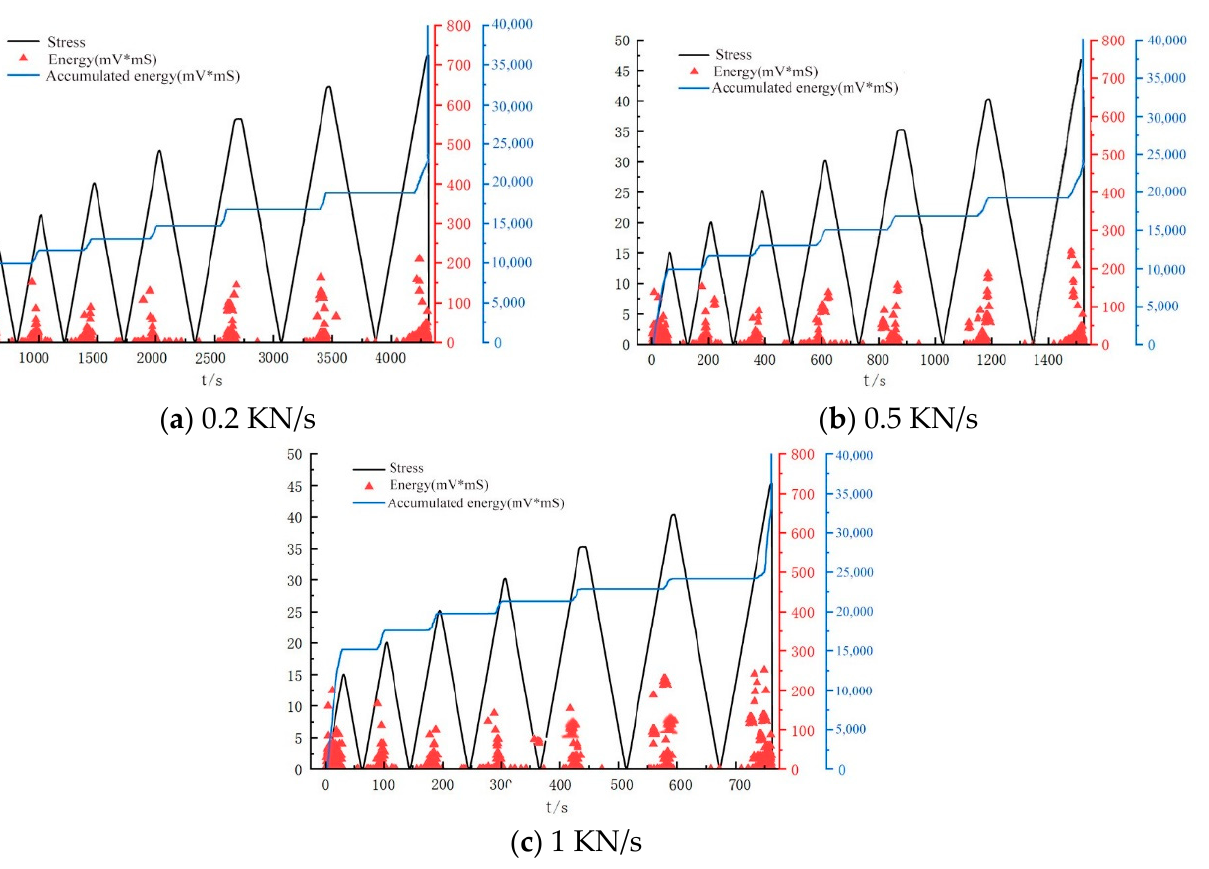
Figure 15. Acoustic emission characteristics of sandstone. The test results show that there is a relatively active acoustic emission signal at the beginning of loading, after which the acoustic emission signal is somewhat weakened, compared with the beginning of loading. With the continuation of cyclic loading and unloading, the stress at the unloading point increases, and the redeveloped microcracks keep appearing. The acoustic emission signal tends to be active, and the acoustic emission energy increases. This means an increase in dissipated energy, which is consistent with the aforementioned dissipation energy calculation results. When the load approaches the peak stress, acoustic emission is significantly active, and energy appears to increase more significantly, at which time, the microcrack penetrates and the specimen is damaged. In the post-peak fracture stage, the specimen loses the load carrying capacity, and the stored elastic energy is dissipated mainly by the slip friction of the microcrack; the acoustic emission phenomenon disappears at the same time. When the loading stress did not exceed the previous maximum loading stress, there was almost no acoustic emission phenomenon; when the loading stress exceeded the previous maximum loading stress, the acoustic emission phenomenon reappeared and showed a step increase in the cumulative energy curve, indicating that this specimen has Kaiser